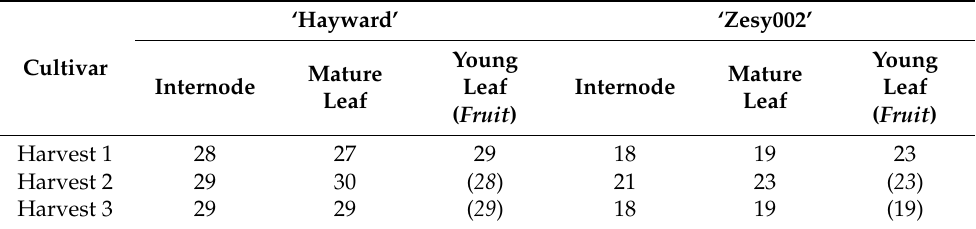
Table 6. Numbers of samples collected from each Actinidia cultivar. Fruit samples are in